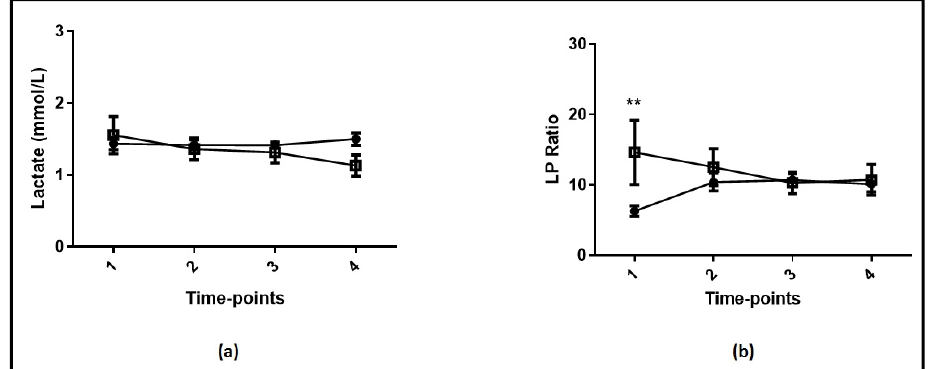
Figure 1. ( a ) Lactate levels at each time-point studied in COVID-19 and non-COVID-19 critically ill patients. ( b ) Lactate-to-pyruvate (LP) ratio at each time-point studied in COVID-19 and non-COVID-19 critically ill patients. Analysis was performed using mixed model fixed effects for lactate levels and the LP ratio over the first 24 h of ICU stay and COVID-19 infection as the grouping factor. Open square, non-COVID-19 critically ill patients; closed circle, COVID-19 critically ill patients. **— p < 0.01 between COVID-19 and non-COVID-19 patients.